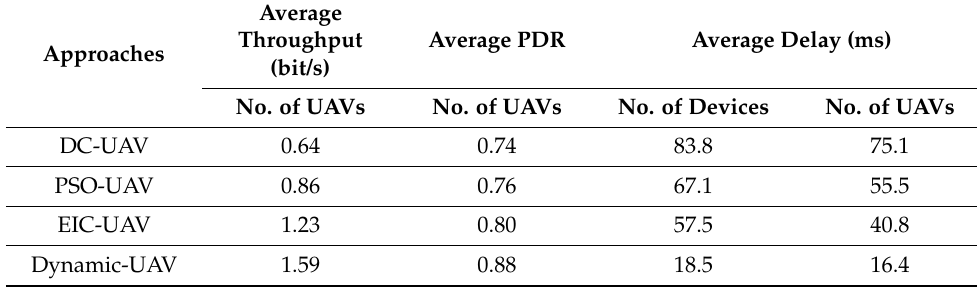
Table 5. QoS analysis.